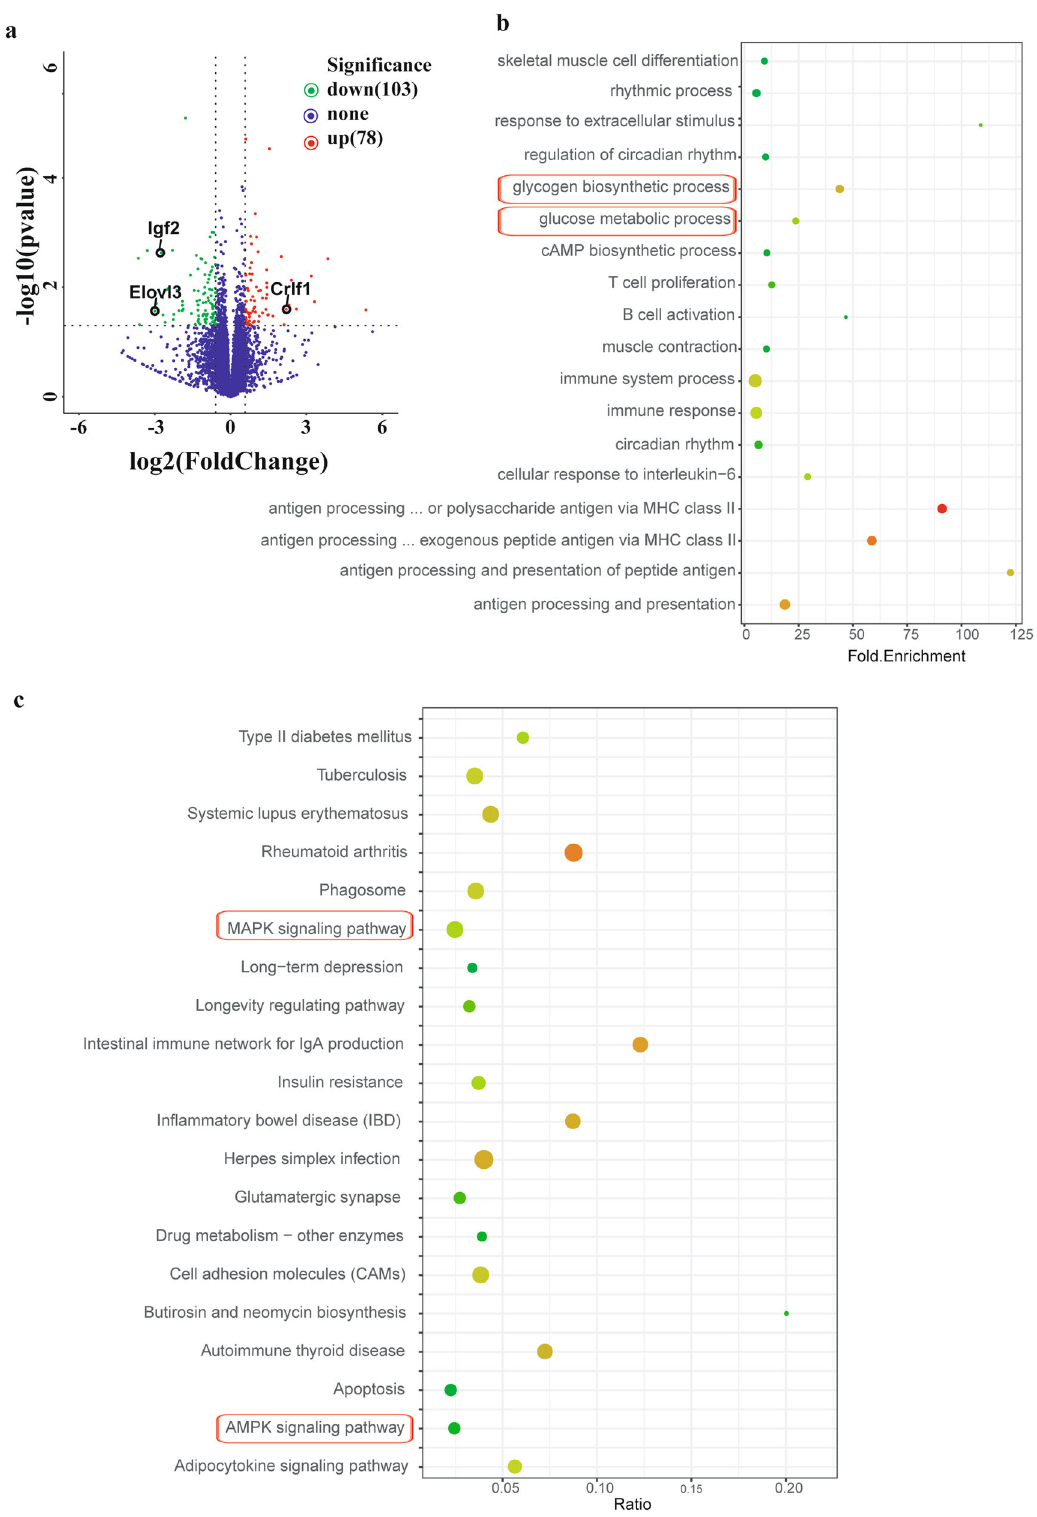
Fig. 3 Visualization of the differentially regulated mRNAs in cardiac tissues of WT and Tecrl KO mice. a Representative volcano plots of differentially regulated mRNAs in the WT and Tecrl KO mice cardiac tissues. Those with P < 0.05 and |fold change| >1.5 are highlighted. b GO analyses of differentially expressed mRNAs. c KEGG analyses of differentially expressed mRNAs ( n =